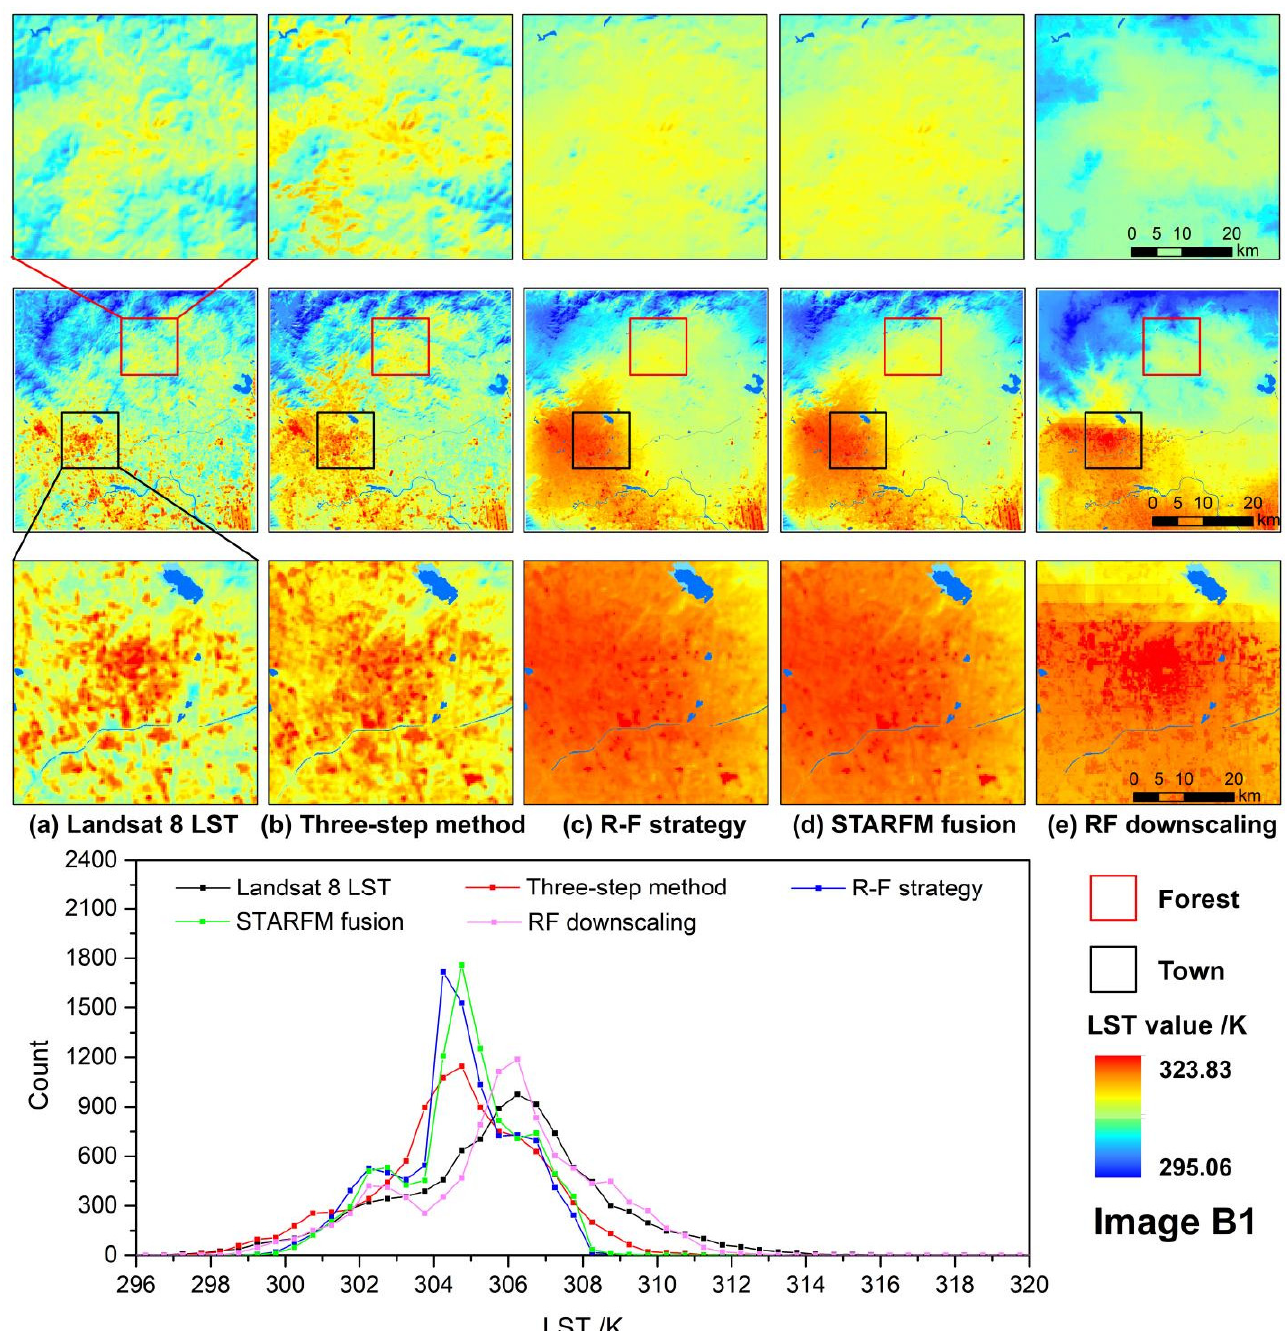
Figure 6. The spatial patterns and frequency distribution curves of predicted LSTs for Image B1: ( a ) Landsat 8 LST product; ( b ) the LST predicted by the three-step method, ( c ) the LST predicted by the RF strategy, ( d ) the LST predicted by the STARFM fusion, ( e ) the LST predicted by the RF downscaling.